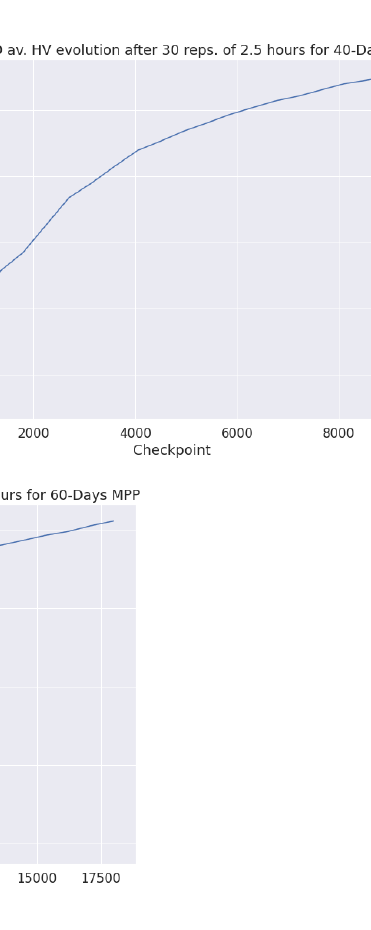
Figure 4. Evolution of the mean HV over the course of the executions, considering menu plans for n = 20 ( upper-left ), n = 40 ( upper-right ) and n = 60 ( bottom )